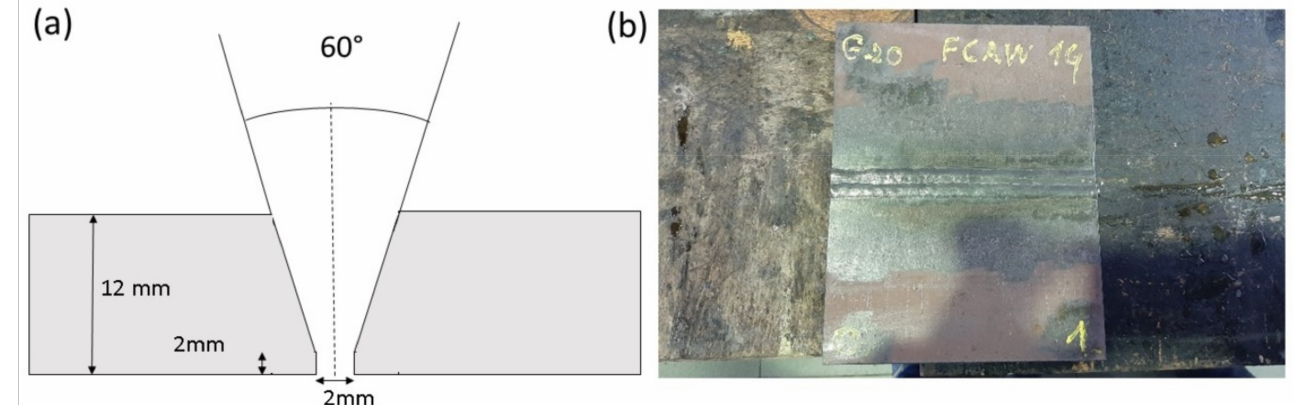
Figure 1. ( a ) Schematic cross-section of the welding probe; ( b ) a finished probe, ready for inspection